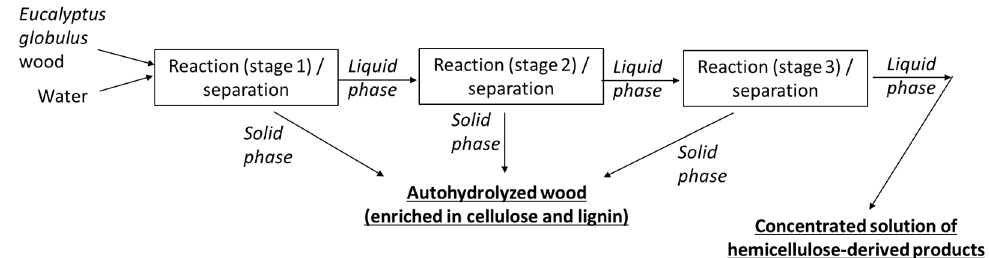
Figure 1. Processing scheme considered in this study.